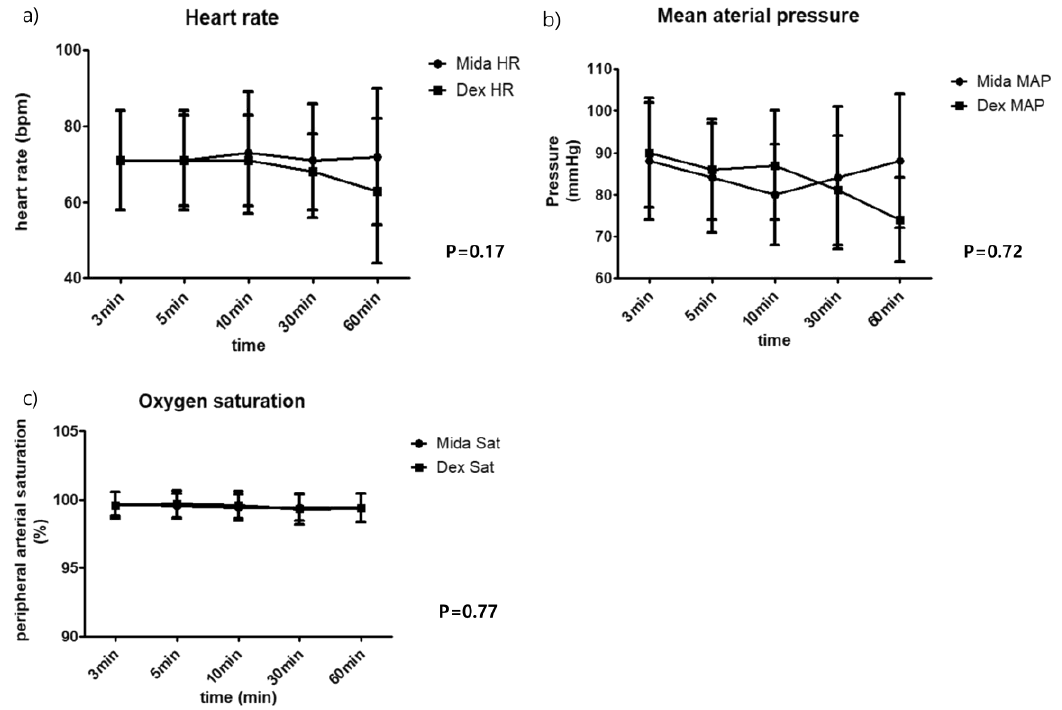
Figure 3. Hemodynamic data: ( a ) heart rate; ( b ) mean arterial pressure; ( c ) oxygen saturation. Table 2. Primary and secondary endpoints.